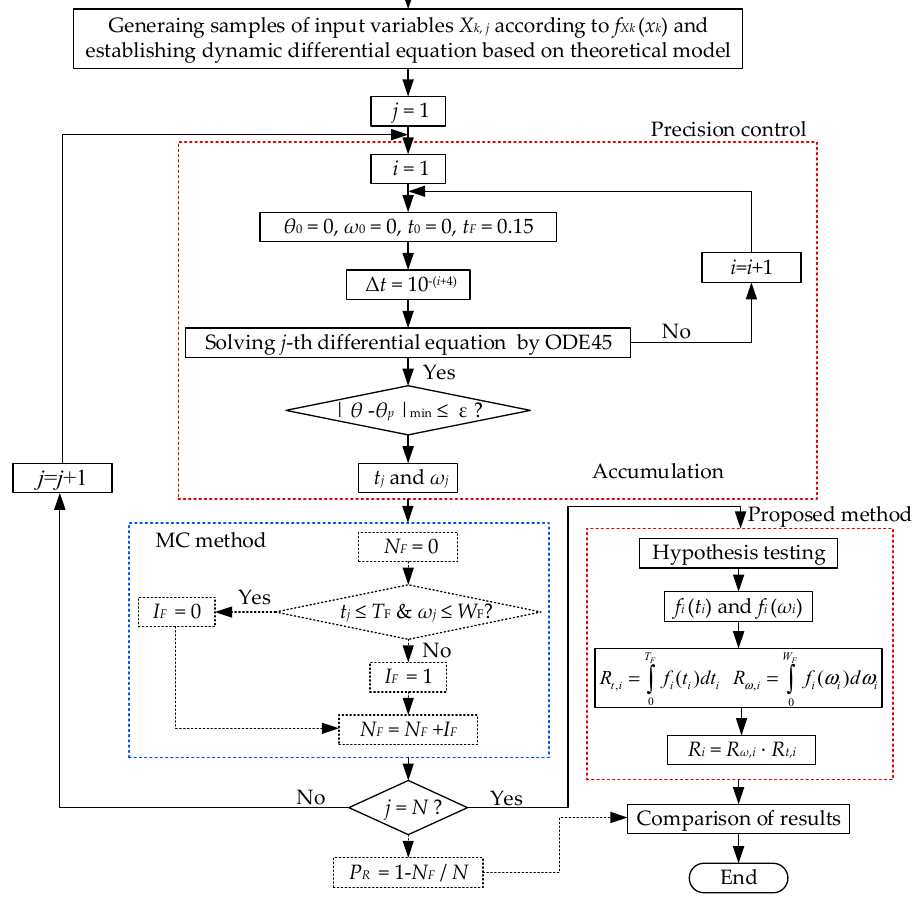
Figure 10. Flow chart for reliability method with precision control of deployable mechanism.